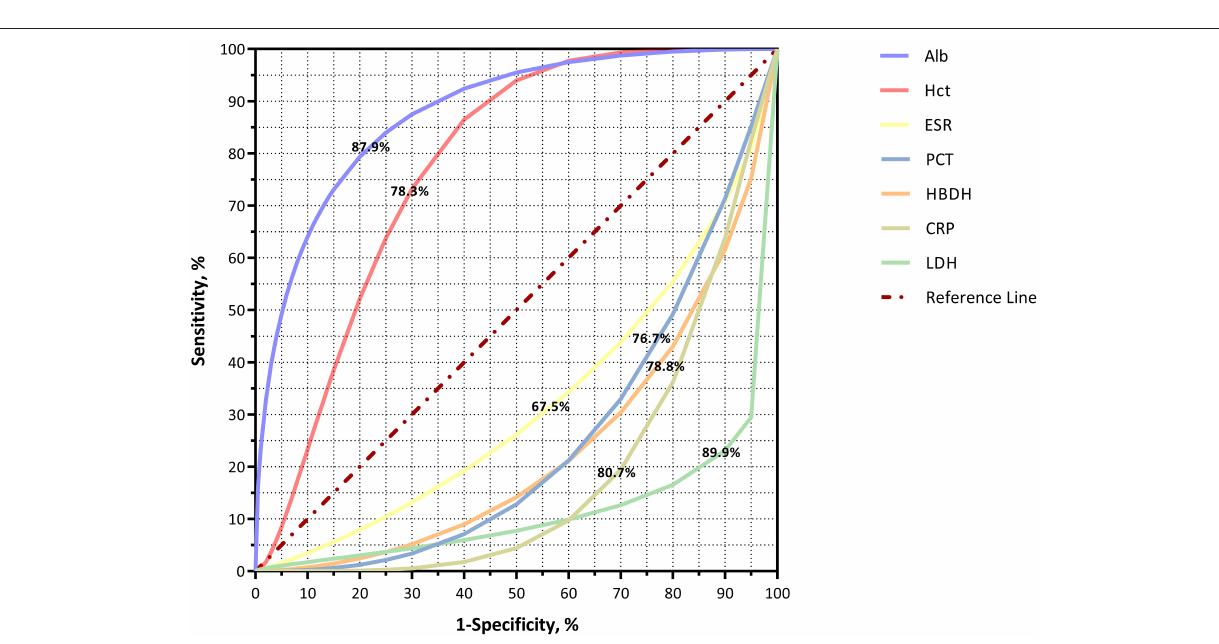
FIGURE 3 | ROC curves for differentiating COVID-19 from influenza